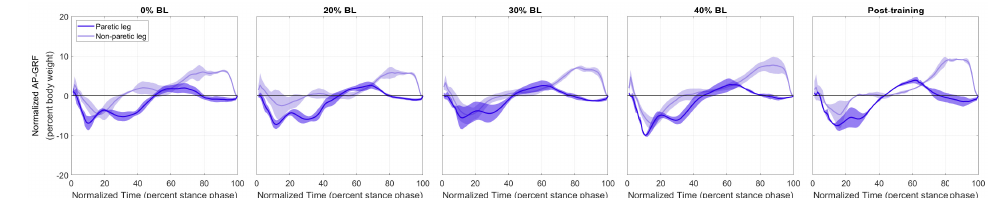
Figure 10. Normalized AP-GRF of the stroke participant. Test conditions are detailed in Table 2. From Figure 11, for the healthy participant, higher GPT resistance led to increased peak propulsion forces by the resisted leg, compared to the unresisted leg (see the red horizontal lines in Figure 11), as shown by the one-tailed nonparametric Fisher–Pitman permutation test under the 30% BL ( p = 0.014), 40% BL ( p < 0.001), 50% BL ( p = 0.004), and 60% BL ( p = 0.002) conditions. We also performed the one-tailed Fisher–Pitman permutation test for each leg between the pre-training condition and each of the subsequent conditions (see the red ‘ > ’ and ‘ < ’ symbols). Significantly increased peak propulsion force was found in the 40% BL ( p = 0.019), 50% BL ( p = 0.004), and 60% BL ( p = 0.029) conditions in the resisted leg. For the unresisted leg, normalized normalized peak propulsion decreased in the 40% BL condition ( p = 0.044) but increased in the post-training condition ( p = 0.029). For the stroke participant, the non-paretic leg always generated significantly higher peak propulsion forces than the paretic leg ( p < 0.028 in all conditions, see the blue horizontal lines). In addition, significantly increased peak propulsion forces were found in the paretic leg in the post-training condition ( p = 0.048), compared to the 0% BL condition (see the blue ‘ > ’ symbol).